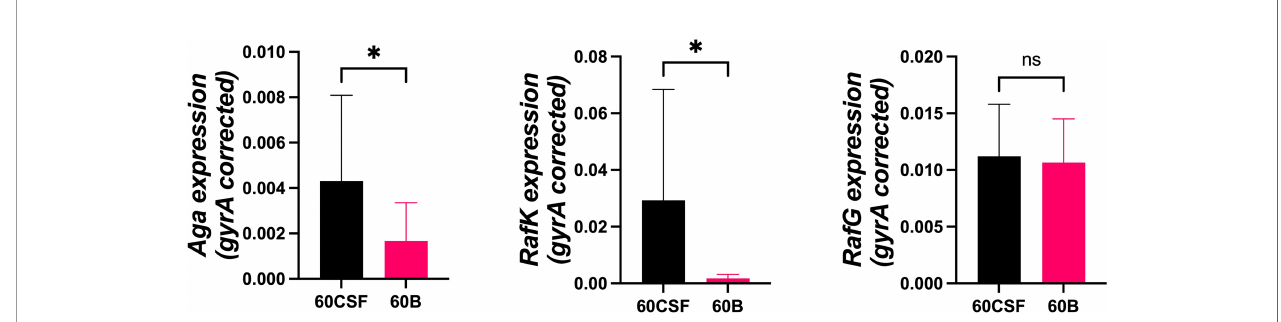
FIGURE 4 | Expression of RafR-regulated raf fi nose pathway genes by 60B and 60CSF isolates. Strains were grown to OD 600 0.2 in CDM + glucose and then washed and resuspended in CDM + raf fi nose and incubated at 37°C for a further 30min. RNA was then extracted, and levels of aga , rafK , and rafG mRNA were analyzed by qRT-PCR using gyrA rRNA as an internal control (see Materials and Methods ). Data are mean OD 600 ± standard deviation (SD) from two independent assays. Signi fi cance of differences in gene expression between isolates was determined using two-tailed Student ’ s t test; * P < 0.05. ns, not signi fi